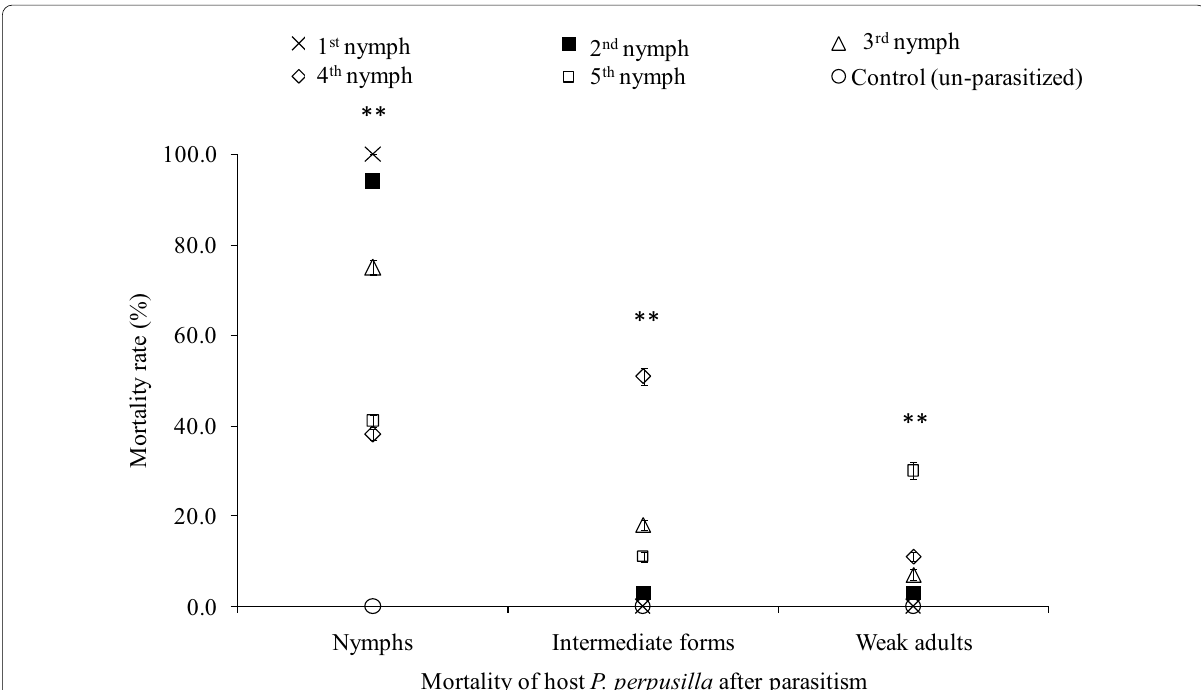
Fig. 1 Mortality of host P. perpusilla as nymphs, intermediate forms (nymph-adult or adult nymph) or weak adults when various nymphal stages were offered to parasitoid F. melanoleuca for parasitism as against un-parasitized nymphs; “**” within a column indicate ( p < 0.05) significant difference; the results are presented as the means SEs ±